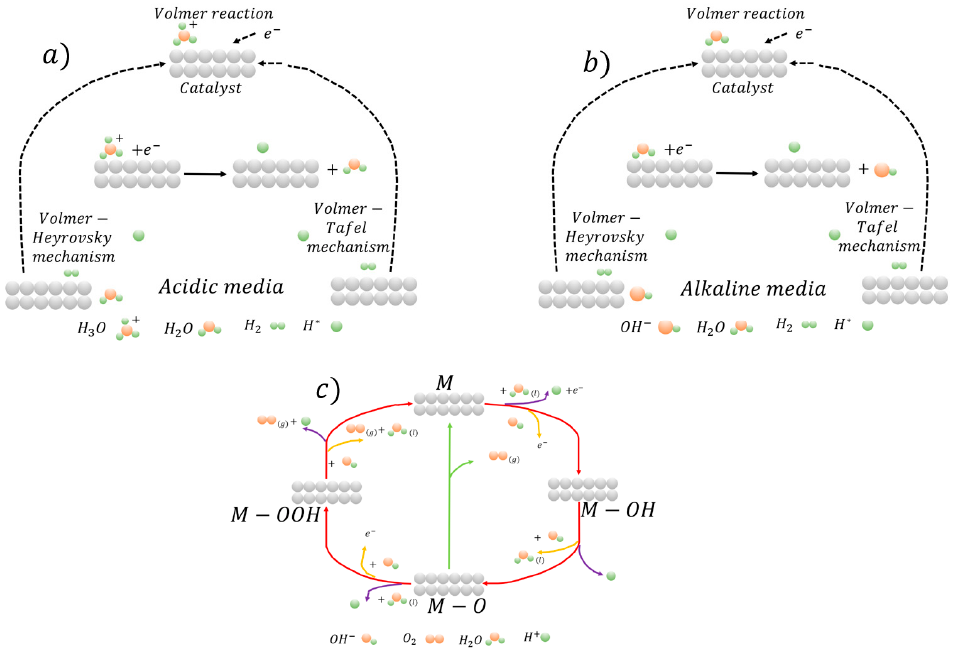
Figure 11. ( a ) HER mechanism in acidic media; ( b ) HER mechanism in alkaline media; ( c ) The oxygen evolution reaction (OER) mechanism in acidic solution (purple line) and alkaline solution in (yellow line).